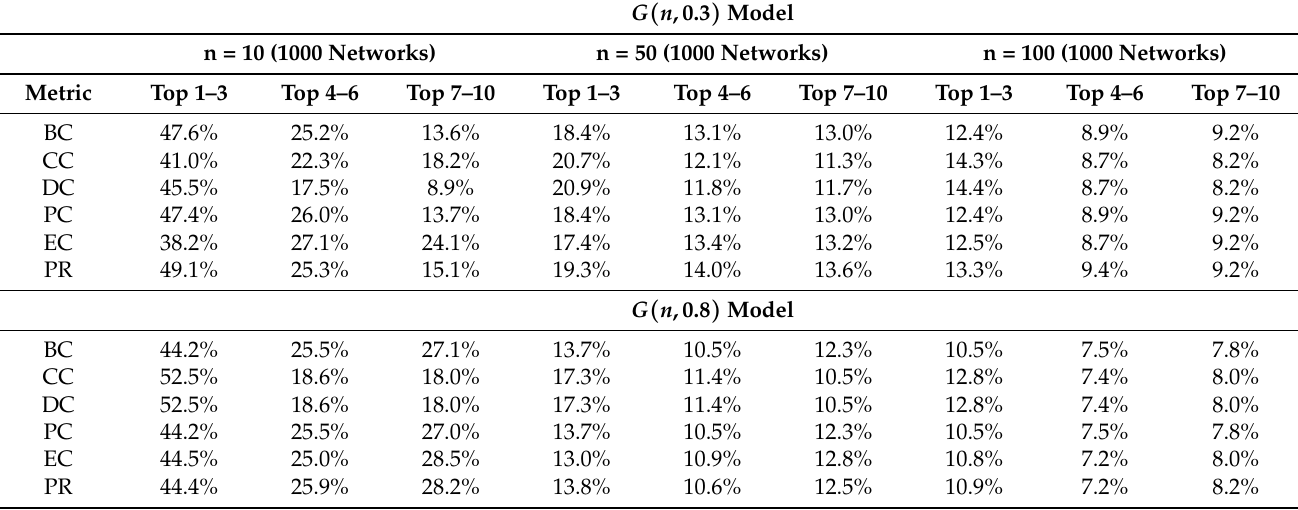
Table 10. Average percentage of HD nodes being top important nodes in different sized Erd˝os–Rényi networks of model G ( n , p )